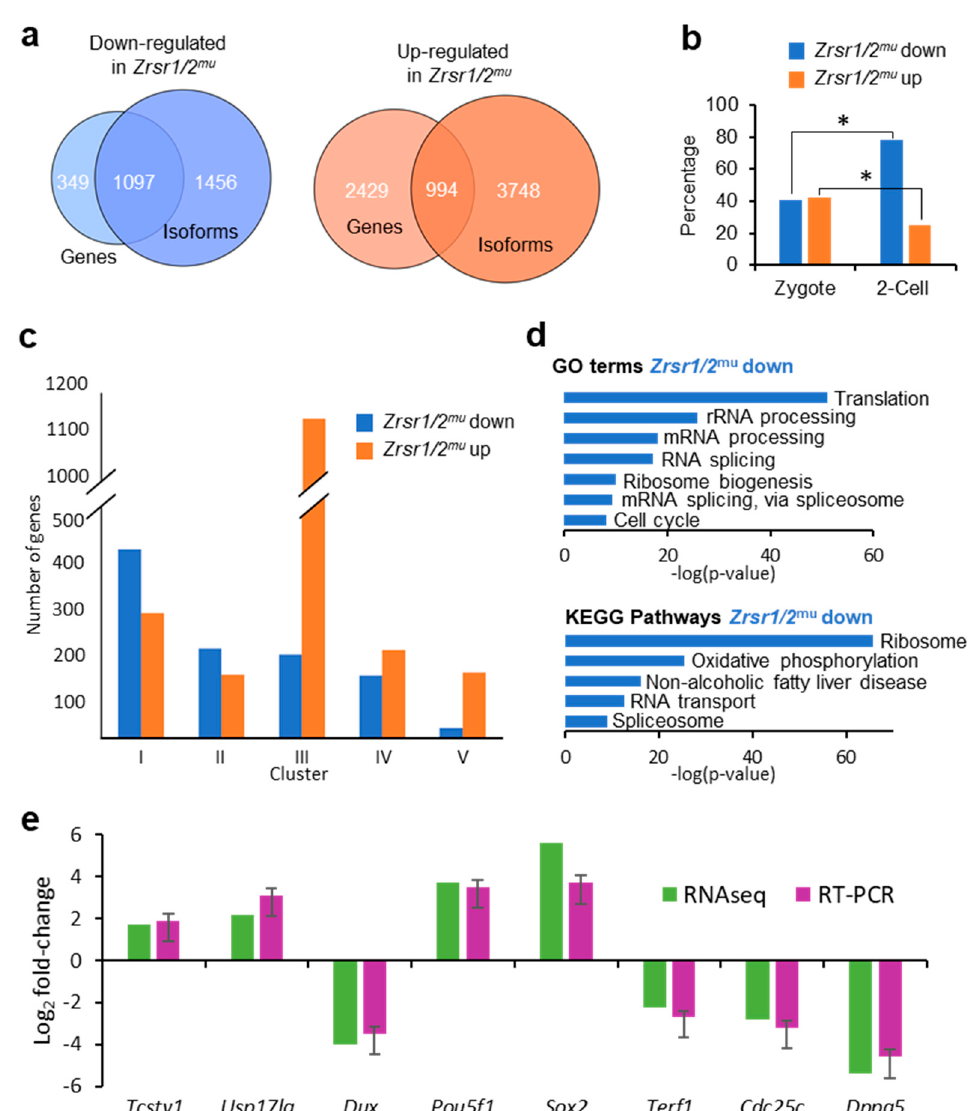
Figure 1. RNA-seq analysis of Zrsr1/2 mu embryos, gene ontology, and RT-PCR validation. ( a ) Venn diagrams comparing up- (orange) or downregulated (blue) genes and isoforms in Zrsr1/2 mu vs. wild-type (WT) 2-cell embryos. ( b ) Percentage of genes up- or downregulated in Zrsr1/2 mu that are present in zygote or 2-cell stages in mice [30]; * p < 0.01 (z test). ( c ) Clustering of differentially expressed genes according to [31]. ( d ) Significant gene ontology (GO) terms (upper panel) and Kyoto Encyclopedia of Genes and Genomes (KEGG) pathways (lower panel) in differentially expressed genes (DEGs) in the pair-wise comparison are indicated. ( e ) Validation of RNA-seq data for differential gene expression by qRT-PCR of selected RNAs from Zrsr1/2 mu and WT 2-cell embryos (3 pools of 10 2-cell embryos; triplicate results are presented as the mean ± SEM). No statistically significant differences were found by ANOVA followed by Tukey’s post hoc test ( p < 0.05).